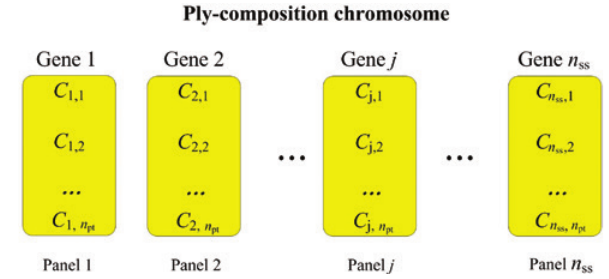
Figure 4: The ply-composition chromosome.